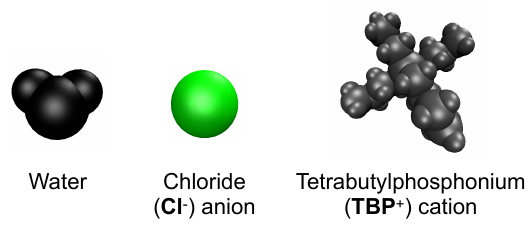
Figure 14. IL and co-solvent molecular representations